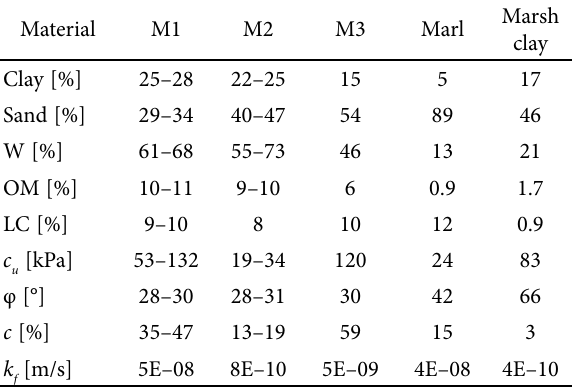
Table 3. Preliminary results of geotechnical characterisation